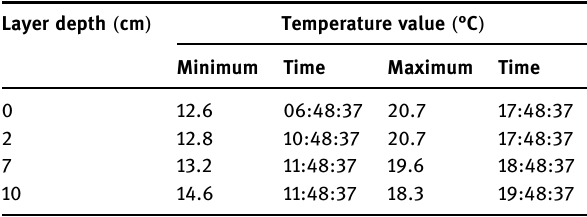
Table 1: The minimum and maximum values of temperature ( °C ) for all layers on Friday, 15 January 2019 Layer depth ( cm